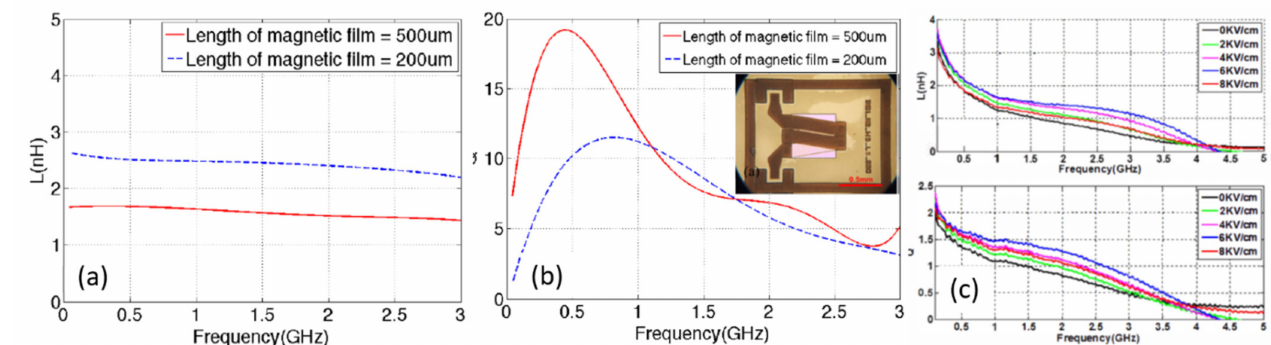
Figure 13. Frequency dependence of ( a ) inductance and ( b ) quality factor of FeGaB/Al 2 O 3 multilayer thin films. ( c ) High tunability of inductance and quality factor under applied electric field for the FeGaB/Al 2 O 3 inductor. The inset of Figure 10b shows the optical image of the inductor. Reprinted with permission from ref. [52]. Copyright 2021 IEEE